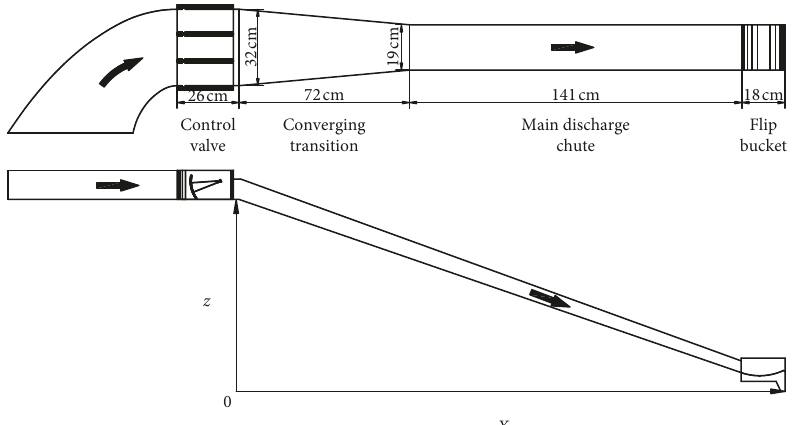
Figure 3: Structure of the open spillway.